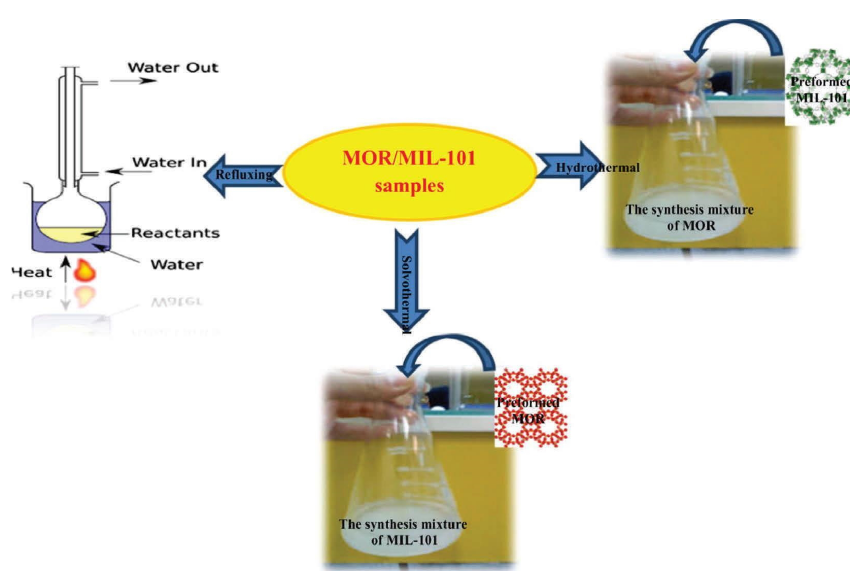
Figure 10: Synthesis of MOR@MIL-101(Cr) composite with three methods adopted from [1].